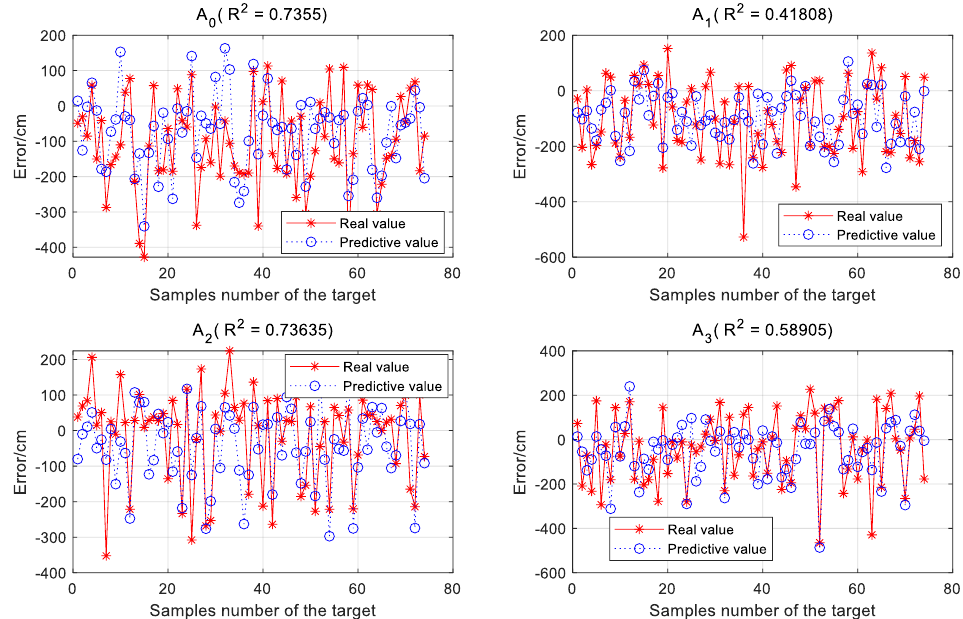
Figure 12. The comparison of ranging errors of each anchor point.